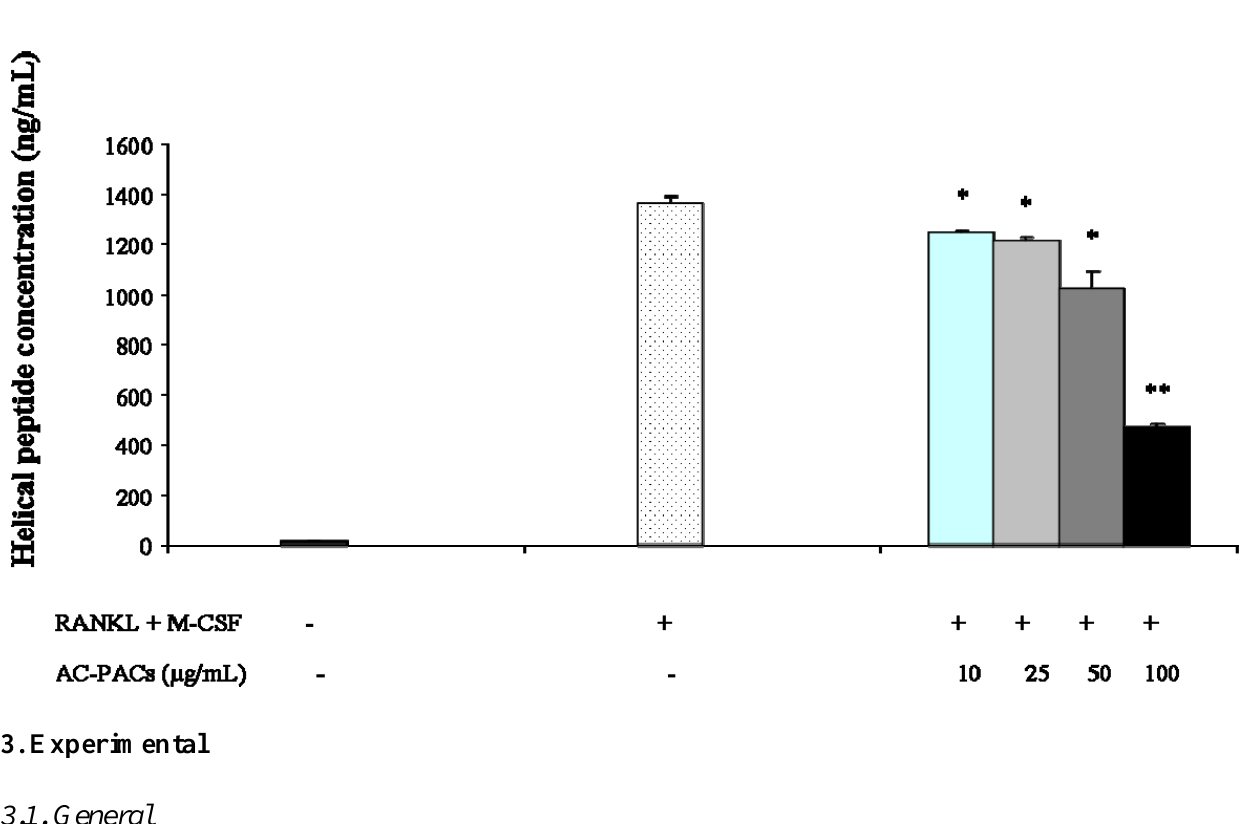
Figure 5. Effect of AC-PACs on bone resorption mediated by osteoclasts. * p < 0.05, ** p <